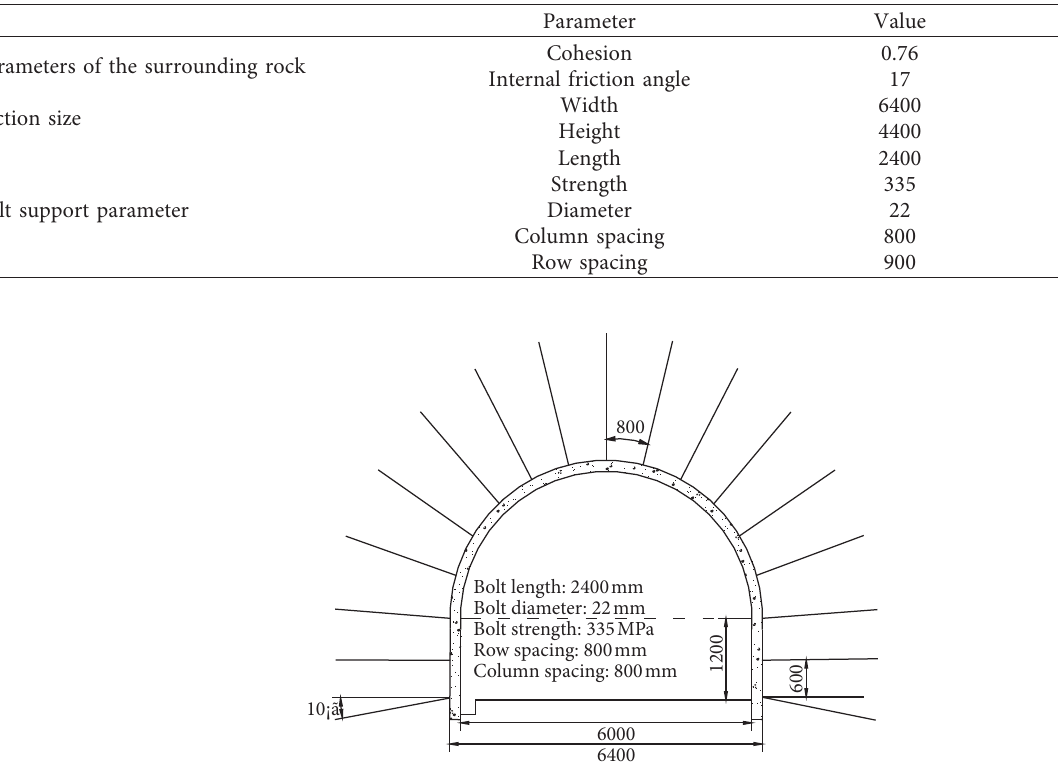
Table 23: Detailed parameters of the main inclined shaft.